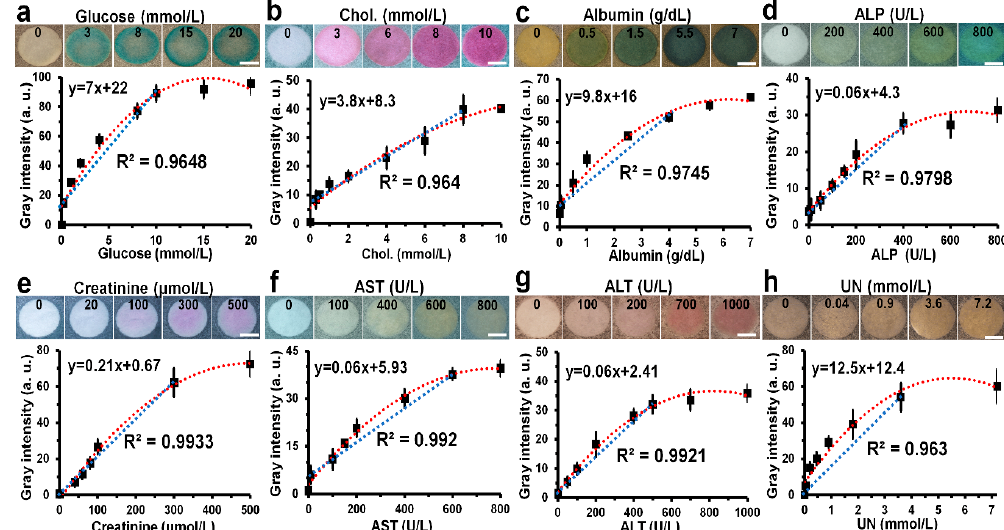
Figure 3. Colorimetric detection of eight biomarkers (glucose, Chol., albumin, ALP, creatinine, AST, ALT, and UN) in PBS. ( a – h ) Dose-response curves were calculated from the data obtained by 15 repeated uses of each analyte at di ff erent concentrations and representative images of the detection zones reacted with various concentrations of a single biomarker: glucose (0–20 mmol / L), Chol. (0–10 mmol / L), albumin (0–7 g / dL), ALP (0–800 U / L), creatinine (0–500 µ mol / L), AST (0–800 U / L), ALT (0–1000 U / L), and UN (0–7 mmol / L). (Scale bar: 4 mm. a.u.: arbitrary units.).